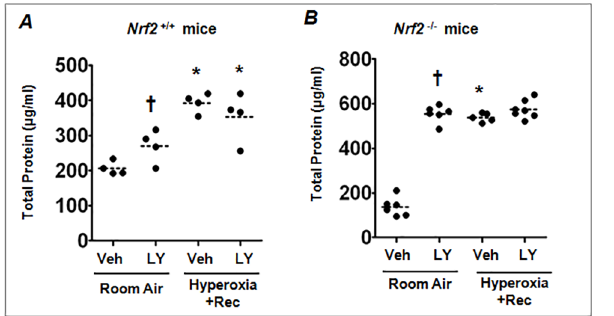
Fig 6. The effects of PI3K/AKT inhibition on hyperoxic lung injury in Nrf2 +/+ and Nrf2 – / – mice post- injury. Nrf2 +/+ and Nrf2 – / – mice were treated with vehicle or LY during hyperoxia as well as post- injury (recovery) from hyperoxia for 72 h at every 24 h intervals. Lung injury and inflammation was assessed as described in Fig 1. Lung alveolar permeability of Nrf2 +/+ (A) and Nrf2 – / – (B) mice post hyperoxic injury. The horizontal and vertical lines were plotted as median ± interquartile range for each group (n = 4 – 5). One- way ANOVA with Bonferroni corrections was performed for multiple group comparisons. * P = 0.05, hyperoxia vs room air; † P = 0.05, vehicle vs LY treated